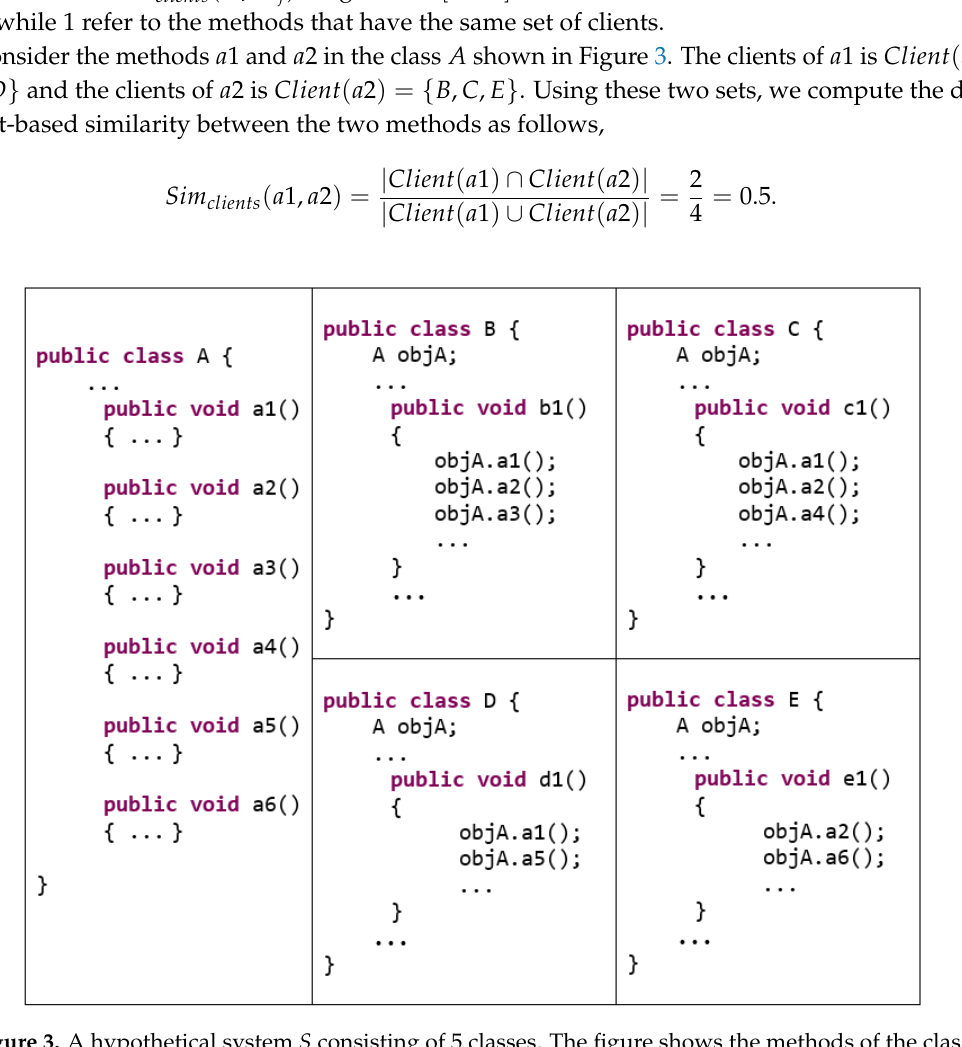
Figure 3. A hypothetical system S consisting of 5 classes. The figure shows the methods of the class A that are used by the other classes (the clients of A ). The unnecessary implementation details of the classes and methods are